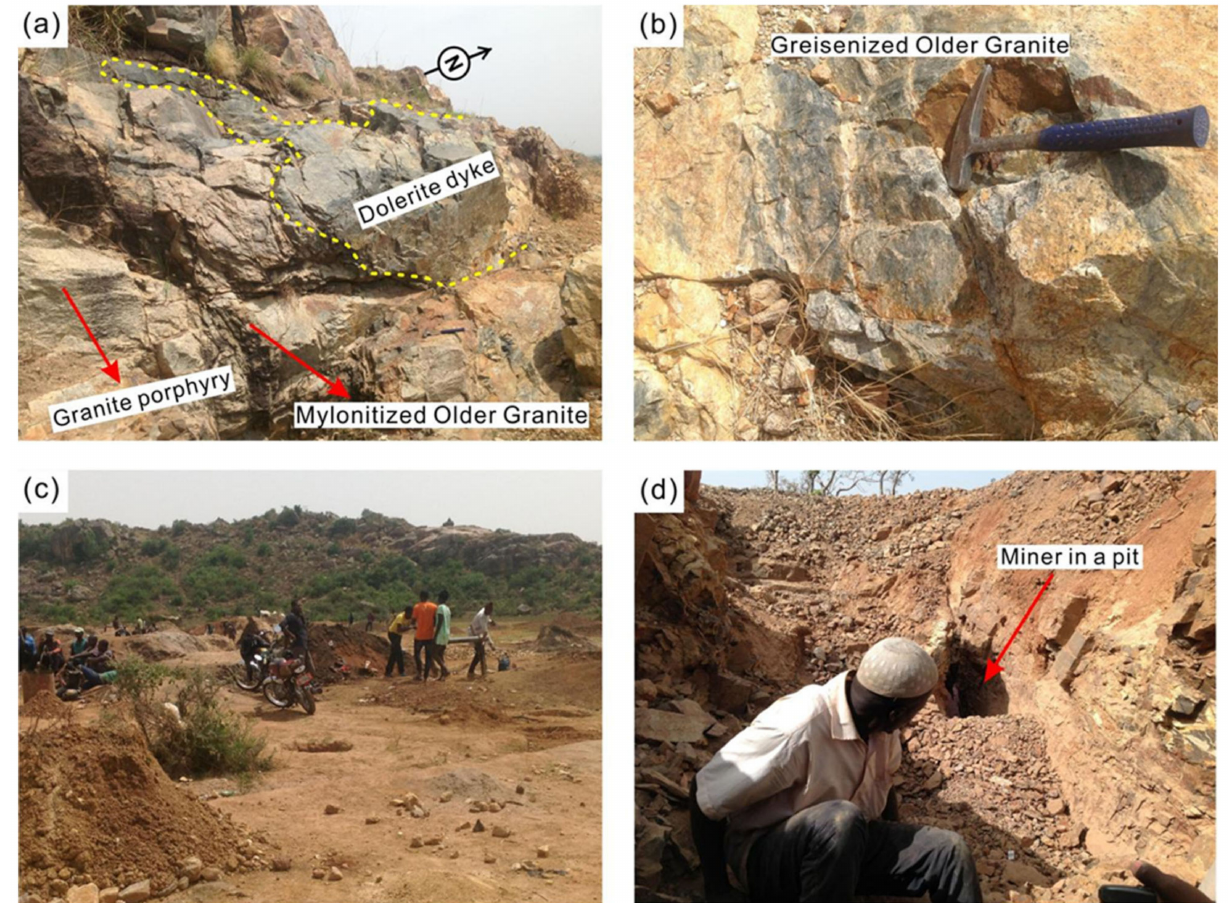
Figure 3. Field photographs that show the contact relationship of igneous rocks and mining scenarios from the Gindi Akwati deposit. ( a ) Contact relation between the Jurassic granite porphyry intrusion (belonging to Younger Granite) and mylonitized Older Granite with dolerite dyke; ( b ) Greisenized Older Granite in the vicinity of the host rock contacted with the granite porphyry; ( c ) Artisanal miners mined alluvial cassiterites close to the roof zone of the biotite granite outcrop; ( d ) Miner dug pits at the marginal contacts (greisenized parts of Older Granite) between the granite porphyry and Older Granite to mine cassiterites in the greisenized granites and quartz